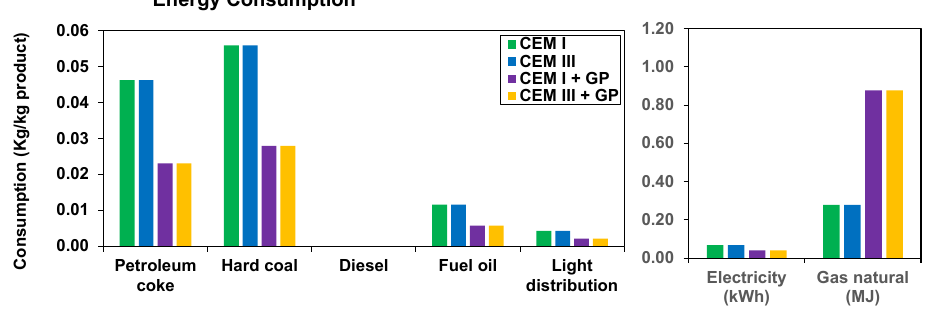
Figure 7. Energy consumption results.